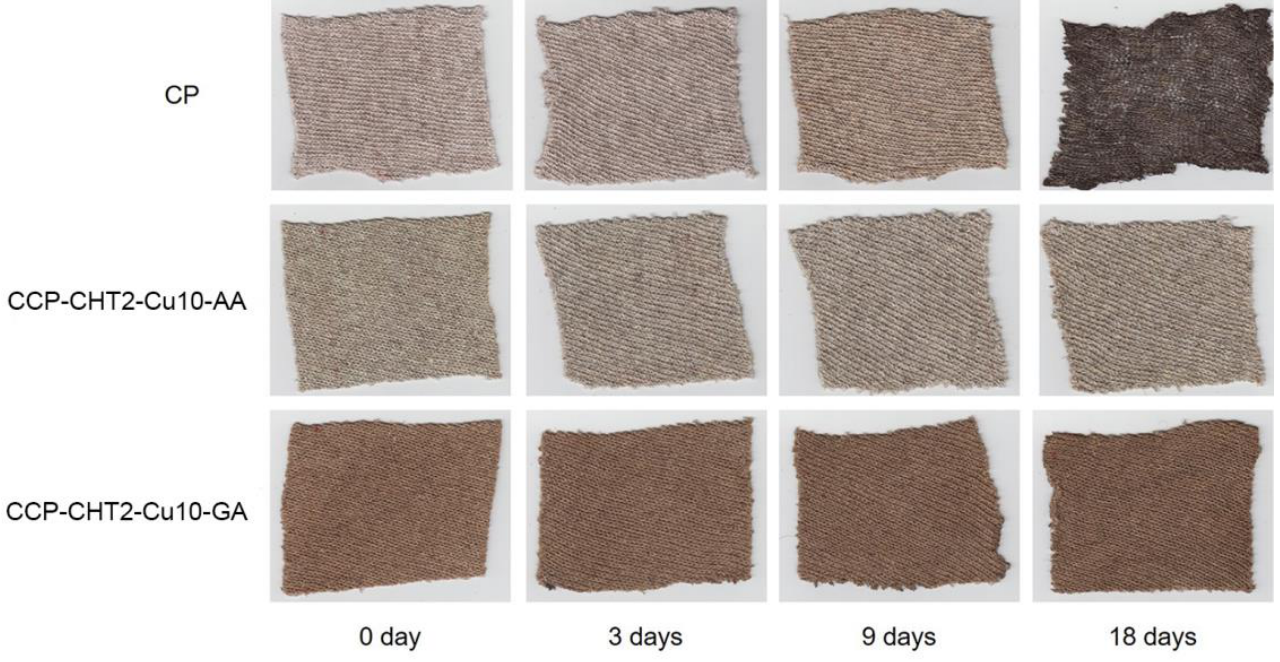
Figure 11. Photographs of studied samples before (0 days) and after 3, 9, and 18 days of soil burial (the sample size: 10 cm × 8 cm).